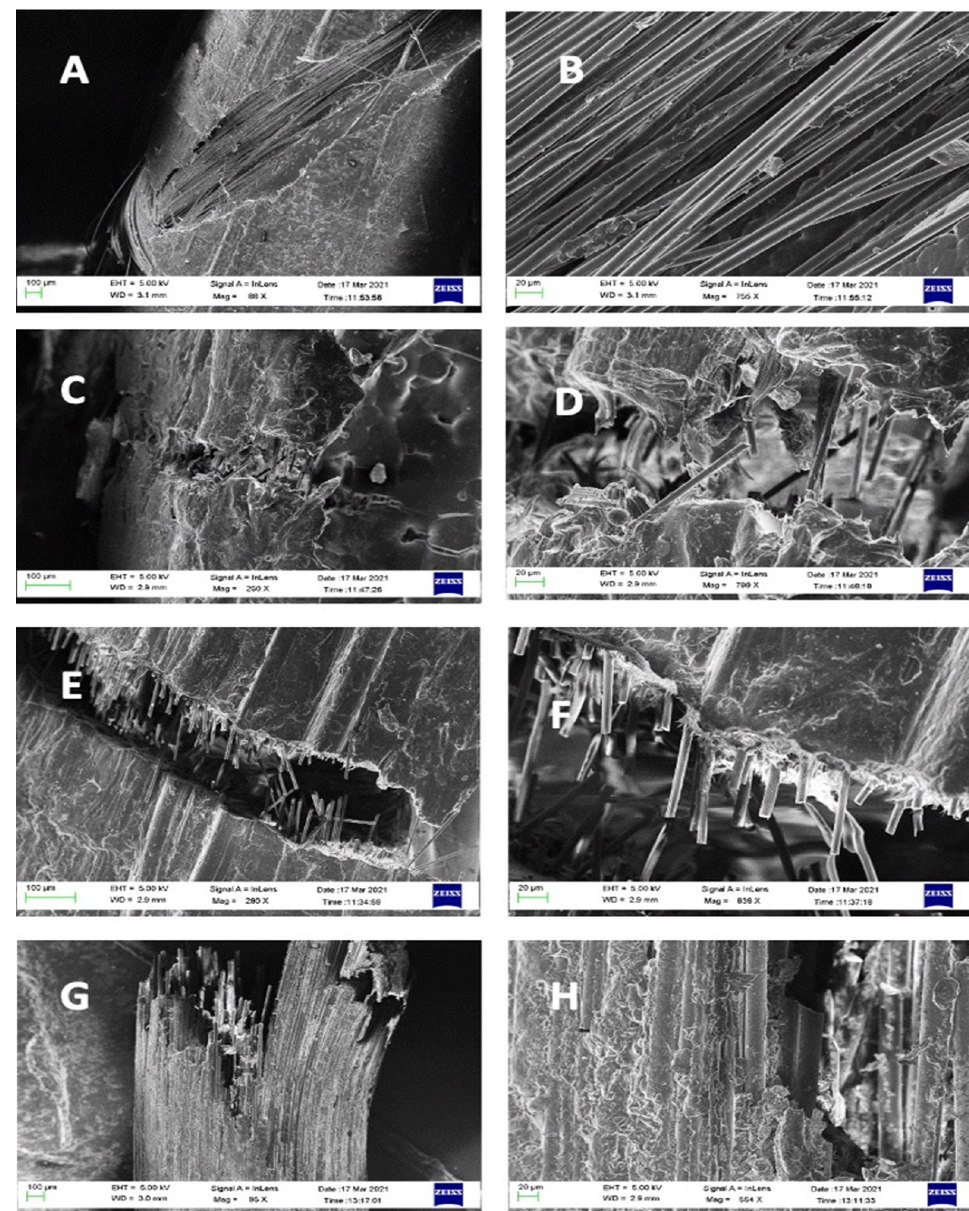
Figure 4. SEM images of FRCPs after two-point bending test showing, ( A , B ) fiber post with pure GF core and sheath composition of 80/20% (PP/GF) with cracking on the surface and most of fibers appear intact and parallel to long axis of the fiber post ( C , D ) fiber post with mixed core and S-GF glass fiber showing once breakage within the sheath goes easier within core due to less GF content, ( E , F ) showing fiber post with pure PP core and sheath with 80/20% (PP/GF). They show almost behavior such as the later type with mixed core, ( G , H ) are the commercial control type 1 (Olipost) the core showing almost breakage of all-GF after reaching the maximum high bending